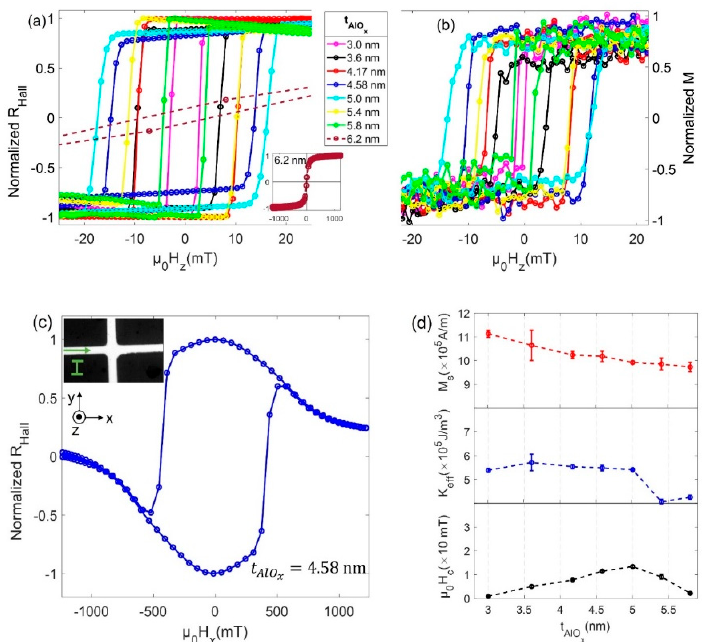
Figure 1. ( a ) Normalized hall resistance, R Hall , as a function of the OOP magnetic field (H z ). The inset on the bottom right is the complete R Hall –H z loop for the Pt (4 nm)/Co (1.1 nm)/AlO x (6.2 nm) sample. ( b ) Normalized magnetization (M) against H z , obtained from the vibration sample magnetometry measurement. ( c ) R Hall as a function of the in ‐ plane field H x for the Pt (4nm)/Co (1.1 nm)/AlO x (4.58 nm) sample. The top left inset is the polar Kerr image of the 27 μ m channel width Hall bar device and the green arrow on it gives the direction of the applied current during the measurement. ( d ) Variation in saturation magnetization (red data points), effective anisotropy (blue data points), and coercivity (black data points) with the AlO x thickness.